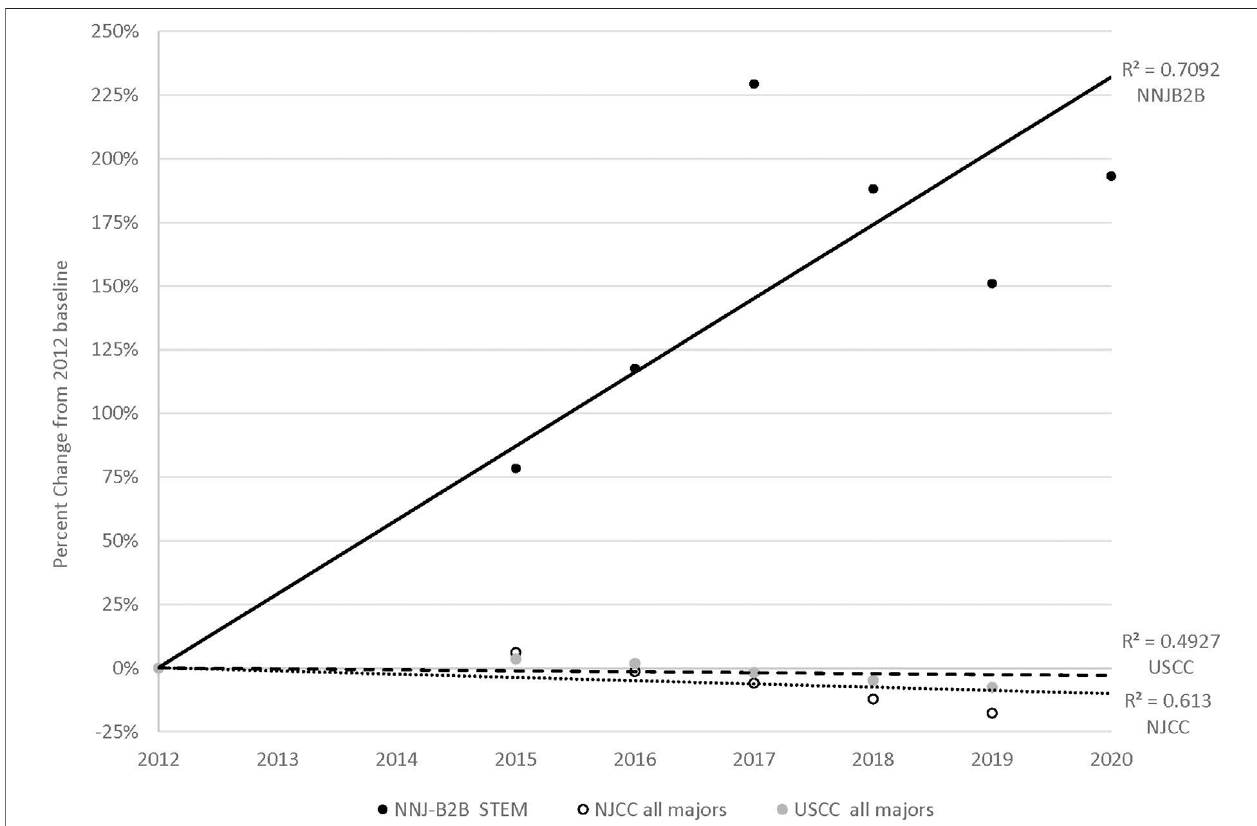
FIGURE 3 | Comparison of URM transfers out in STEM majors from the NNJB2B schools and in all majors from all community colleges in New Jersey (NJCC, n (cid:1) 19) and inthe United States (USCC, n (cid:1) 924) asreported toIPEDS. Datashown aspercent change fromthe 2021baseline. (IPEDSdata for “ Transfers-Out notavailable for